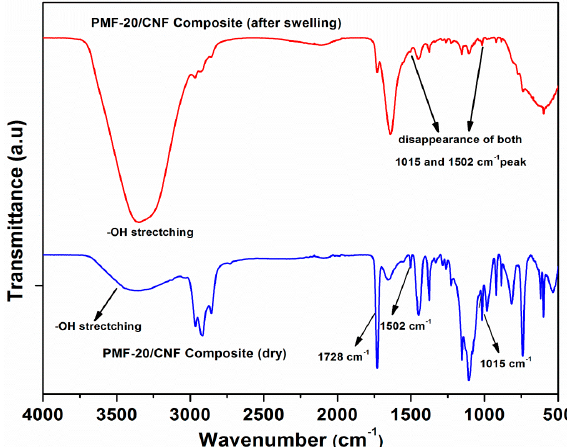
Figure 9. Fourier-transform infrared spectroscopy (FTIR) spectra of PMF-20/CNFs composite (before and after swelling in water).